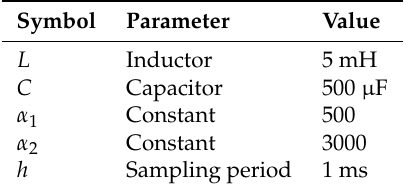
Table 3. Buck converter and DFTSMC parameters.